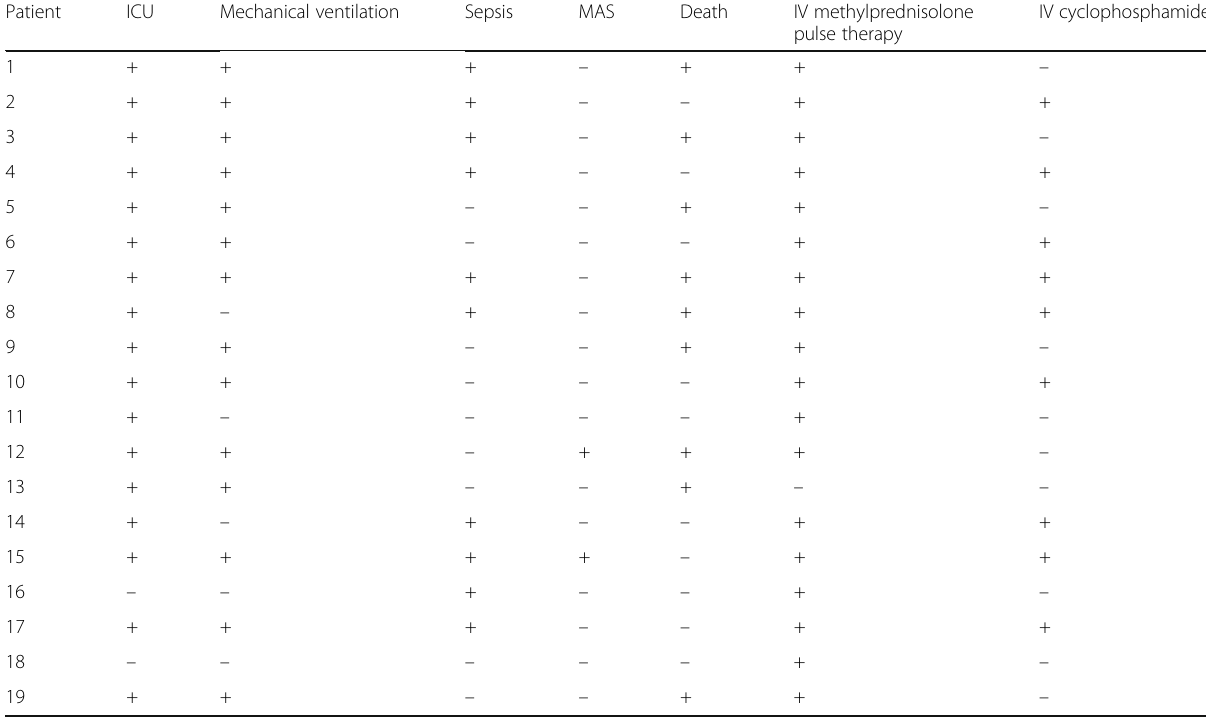
Table 2 Outcomes and immunosuppressive treatment in 19 childhood-onset systemic lupus erythematosus (cSLE) patients with diffuse alveolar